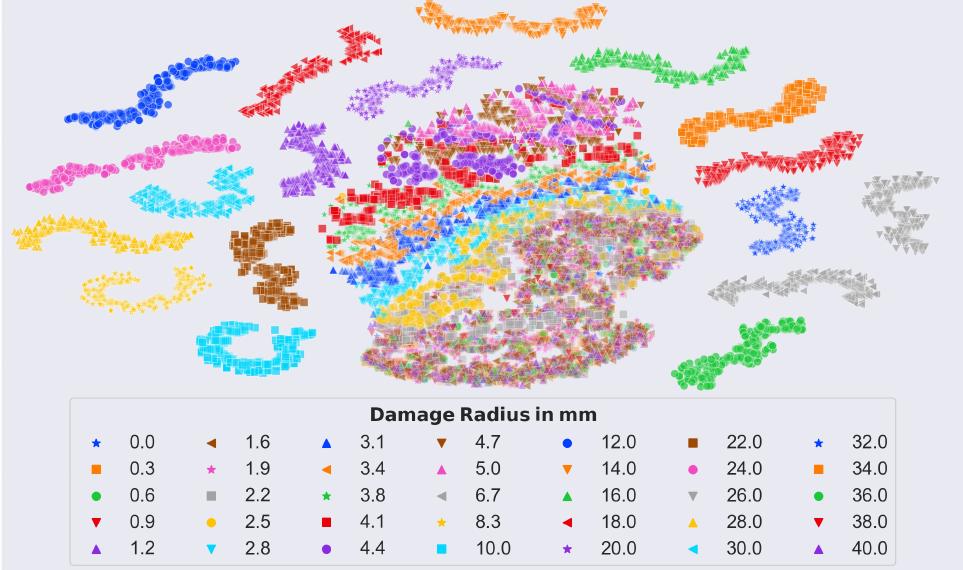
Figure 11. 2D T-SNE embedding of synthetic data of the final frequency range from 1.3kHz to 24kHz, with a clear structure. The big cluster in the center comprises smaller defects up to 5mm, and only very small defects ( < 2 mm) seem to overlap a lot (lower part of the center